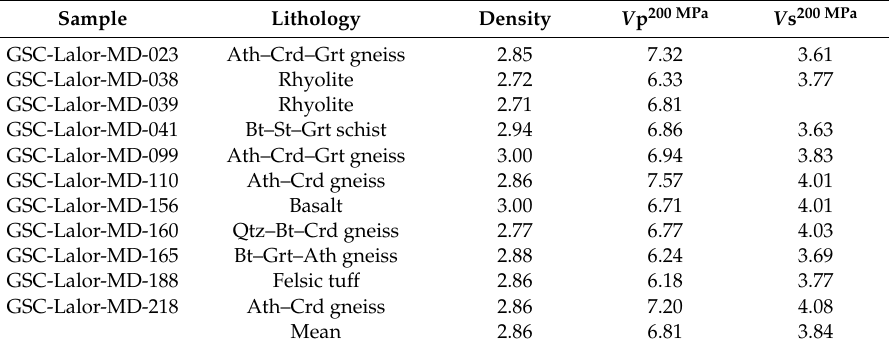
Table 2. Seismic rock properties of drill core samples subjected to SEM-EDS analyses.